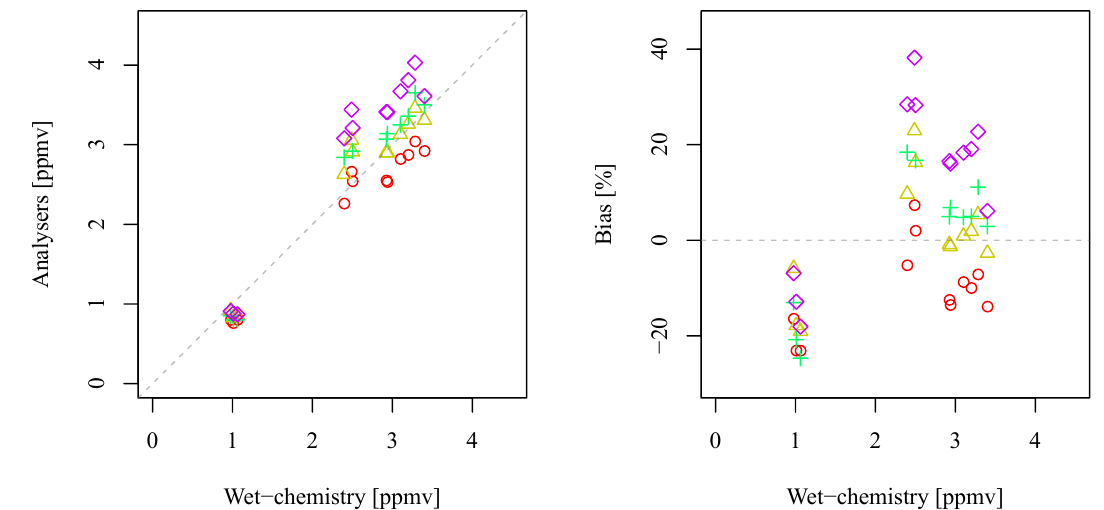
Figure 2. The scatter plot ( left ) and relative bias ( right ) between the wet-chemistry method and five gas analyser ( ◦ INNOVA, (cid:52) Picarro, + Rosemount, (cid:5) Gasmet) measurements on ammonia (NH 3 ) in a poultry barn. The dashed line denotes 1:1 regression.